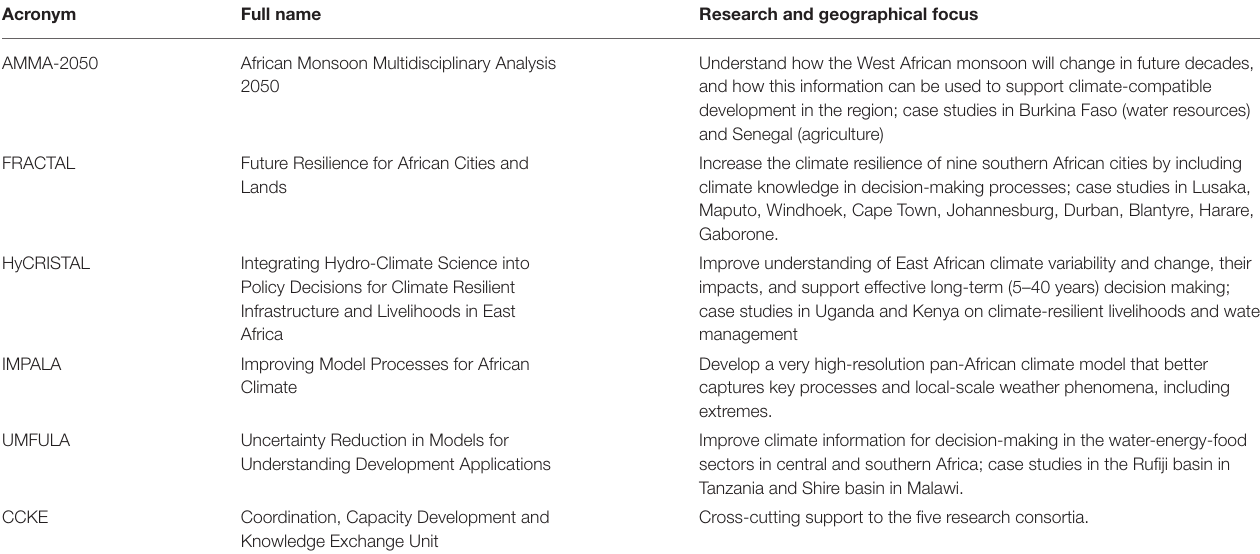
TABLE 1 | FCFA Consortia and their respective focus